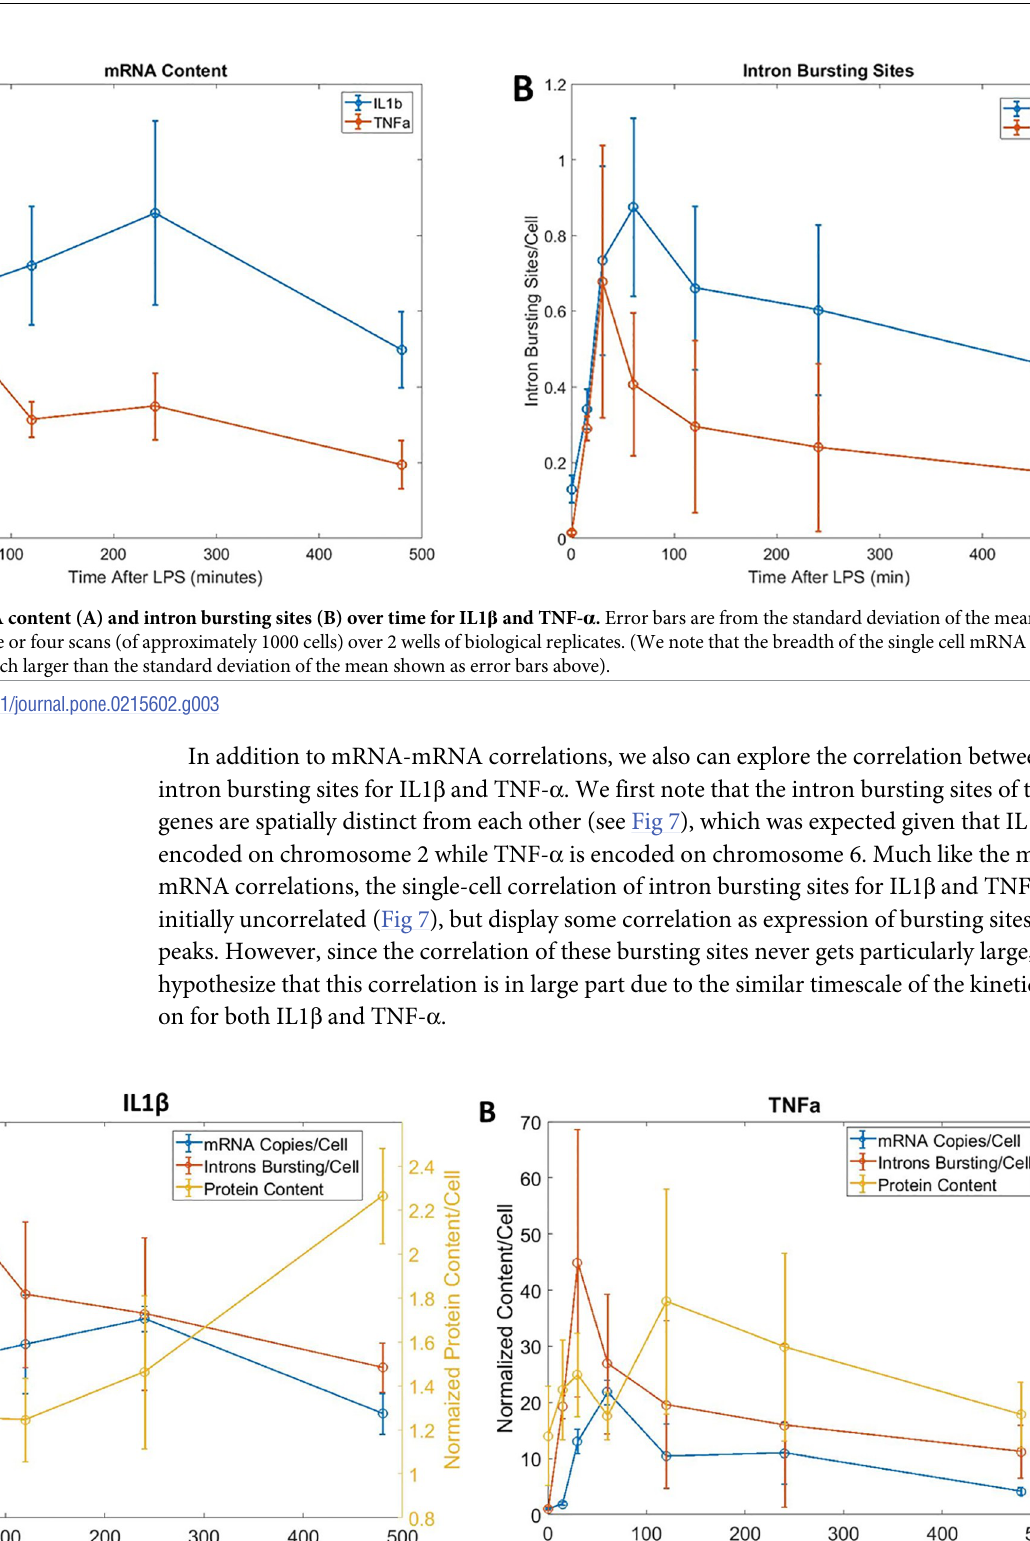
PLOS ONE | https://doi.org/10.1371/journal.pone.0215602 April 19,